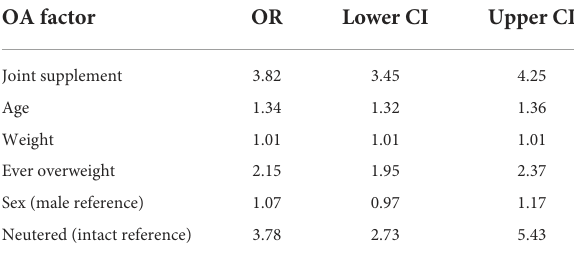
TABLE 2 Odds ratios for factors associated with a clinical diagnosis of osteoarthritis in dogs in the Dog Aging Project cross-sectional cohort. OA factor OR Lower CI Upper